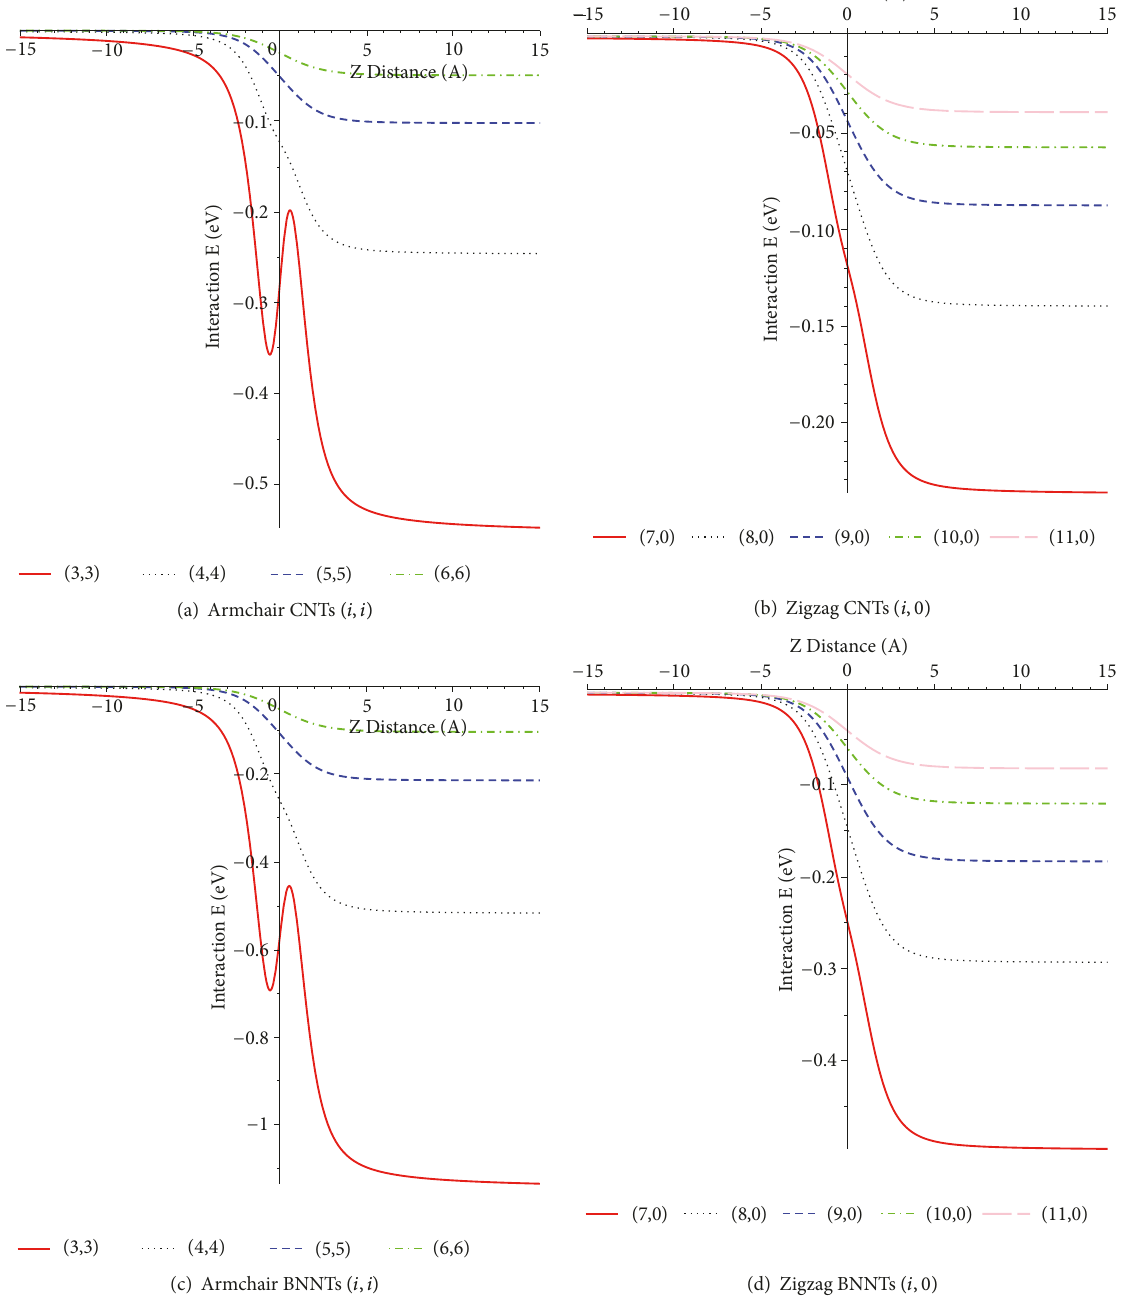
Figure 2: Typical interaction energies for a Ni atom entering nanotubes with different radii 𝑎